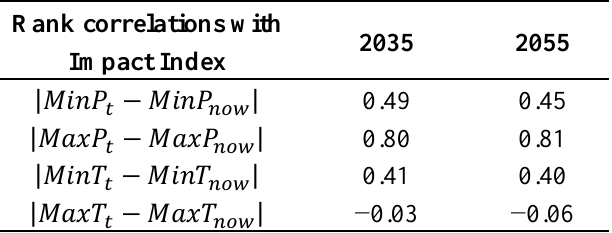
Table 3. Rank correlation of input variables with the Simple Impact Index by year.